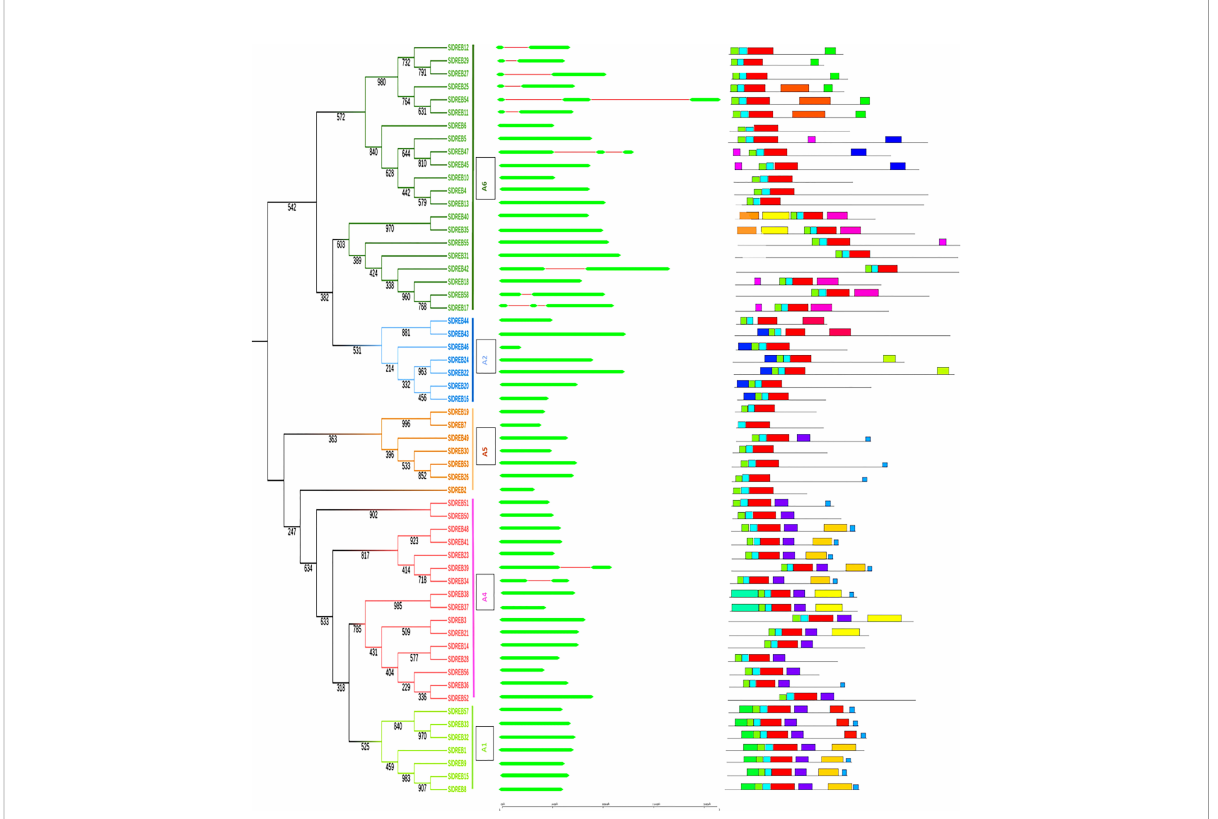
FIGURE 3 Intron – exon organizations of Sl DREB genes. Gene structure was analyzed using Gene Structure Display Server. Here exons and introns are represented with green and red colors, respectively, whereas the scale shows the corresponding sizes of the genes. Twenty motifs predicted through MEME software within SlDREB protein sequences. The motifs were differentiated by distinctly colored boxes, whereas gray lines represented non-conserved